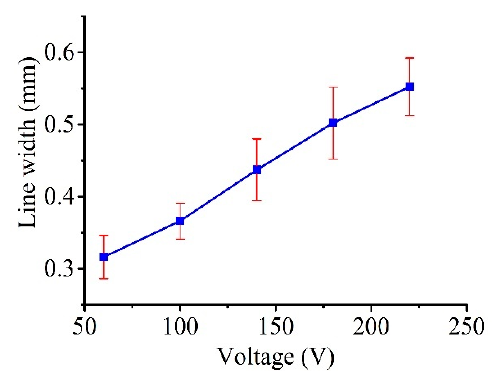
Figure 16. Effect of voltage V s on the line widths.